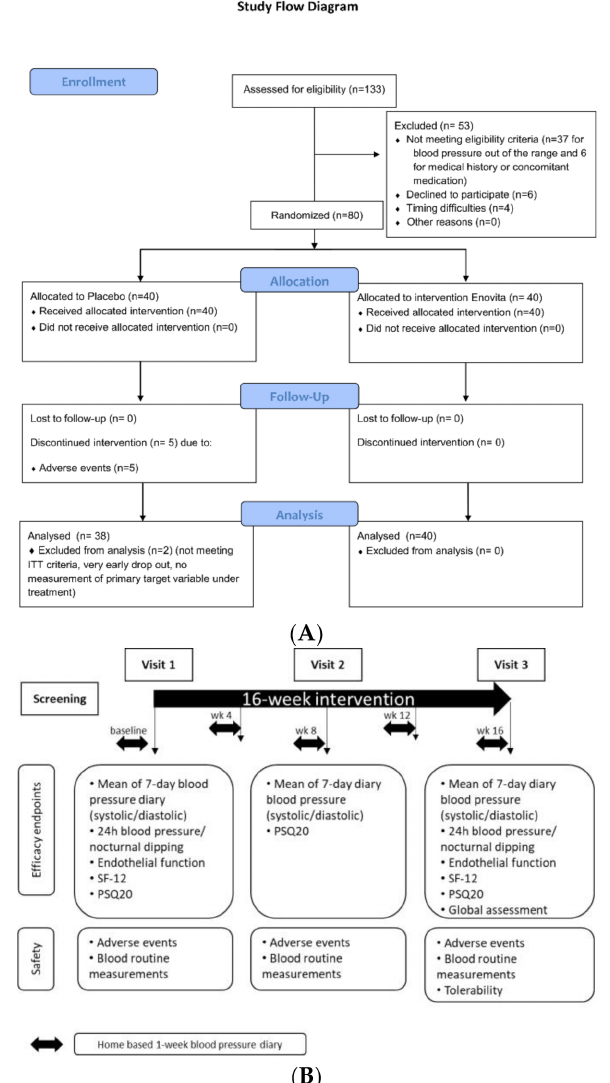
Figure 3. ( A ) Study flow diagram. ( B ) Schematic overview of study design and assessment of endpoints; SF-12: 12-Item Short Form Health Survey; PSQ20: Perceived stress